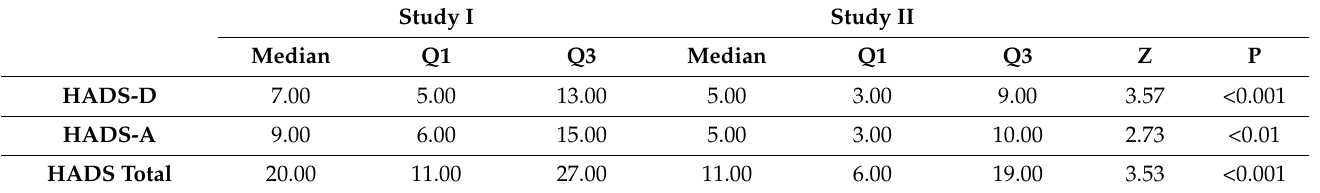
Table 3. Results achieved by patients on the HADS scale during the first and second tests (Wilcoxon test).